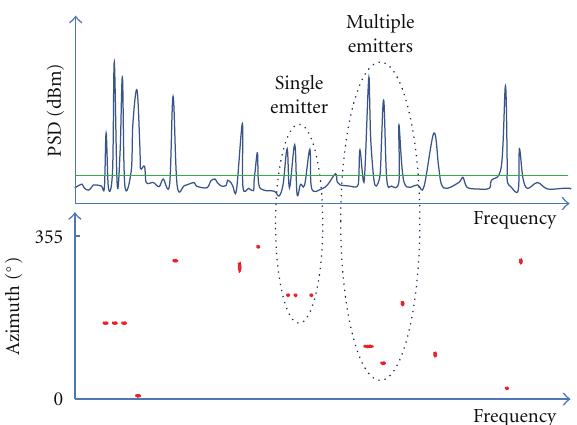
Figure 7: An example of data fusion between spectral and DoA